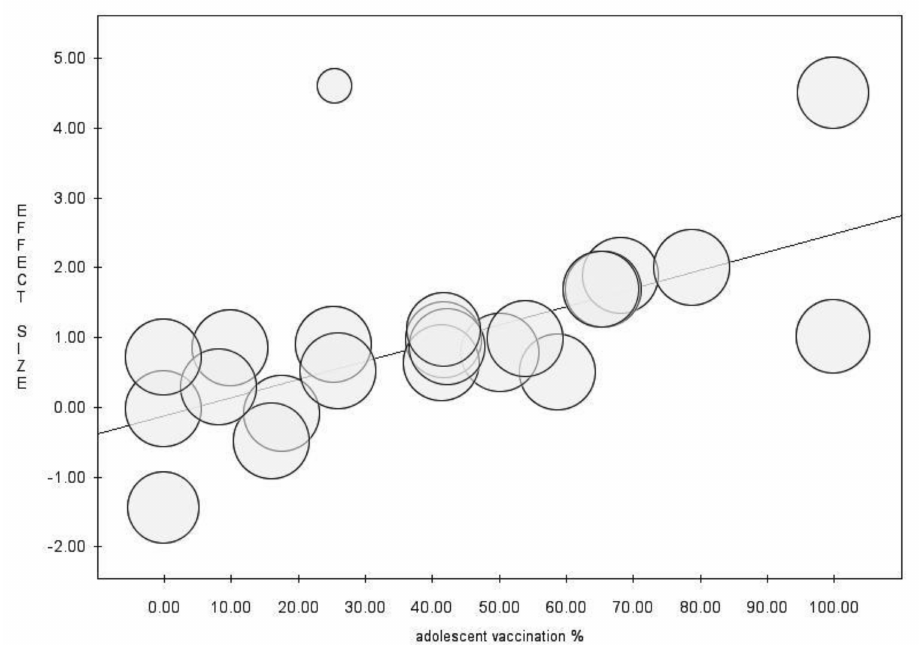
Figure 4. Meta-regression analysis for proportion of vaccination during adolescence, showing positive association with the proportion of seroprotected